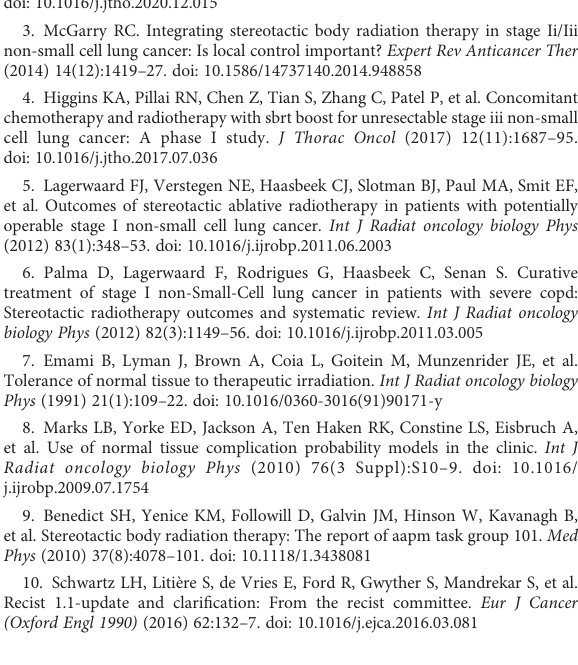
SUPPLEMENTARY FIGURE 1 Schematic Illustration of the two treatment techniques. (A) Depicts the SBRT+MLN approach with SBRTtotheprimary beingillustrated in redand MLN irradiation being illustrated in orange. (B) shows the VMAT only approach illustrated in orange. Chemotherapy was not given during the SBRT portion of the